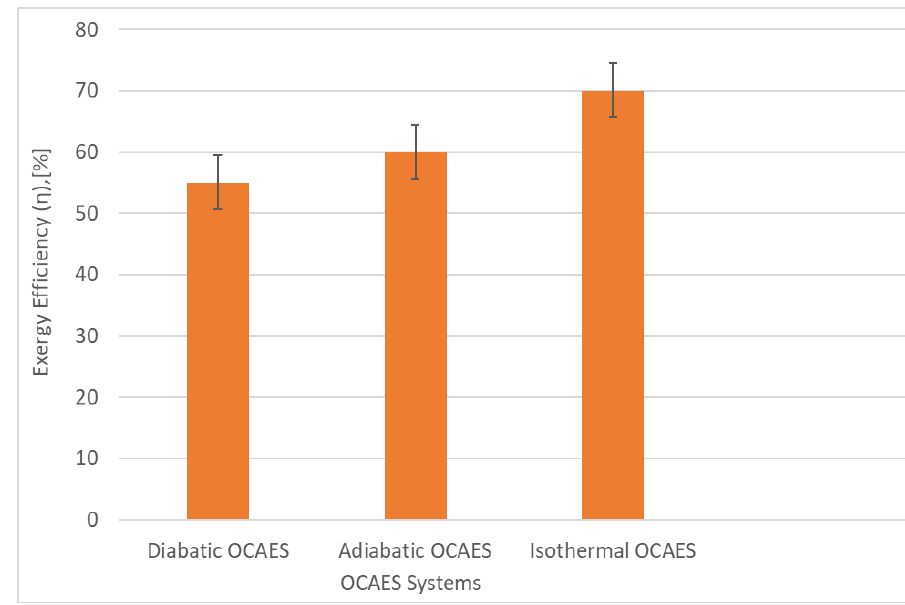
Figure 11. Exergy efficiency of various types of OCAES.